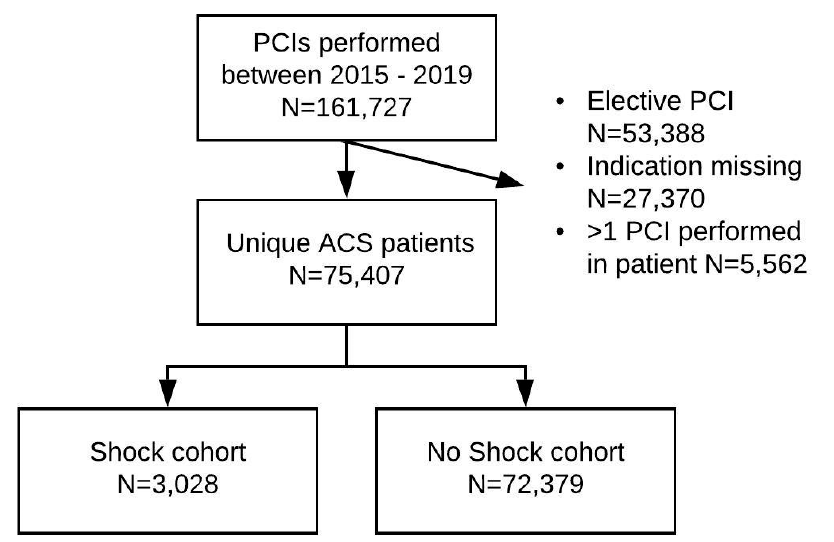
Figure 1. Flowchart of study population: acute coronary syndrome patients treated by percutaneous coronary intervention with ( n = 3028) and without cardiogenic shock ( n = 72,379).